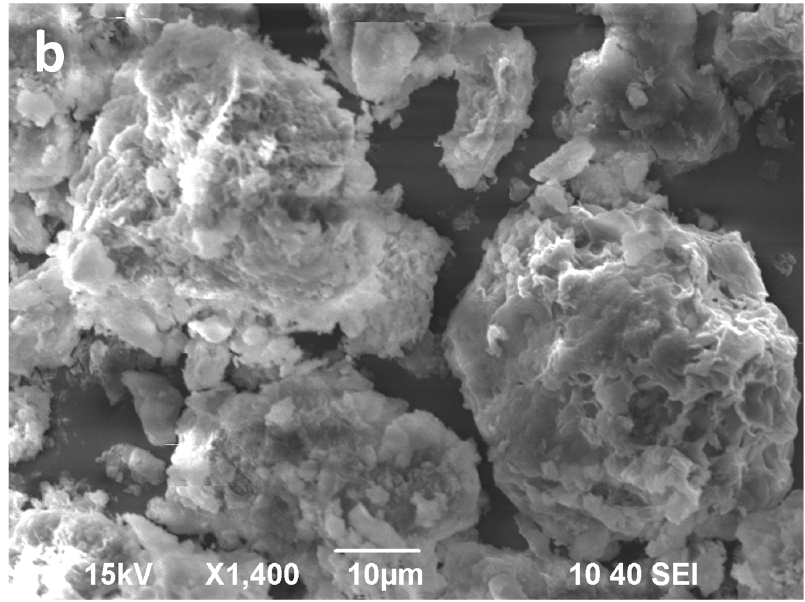
Figure 8. SEM images of the kerolite K1 ( a ) and kerolite K1 after 16 min of microwave-assisted acid treatment ( b ).